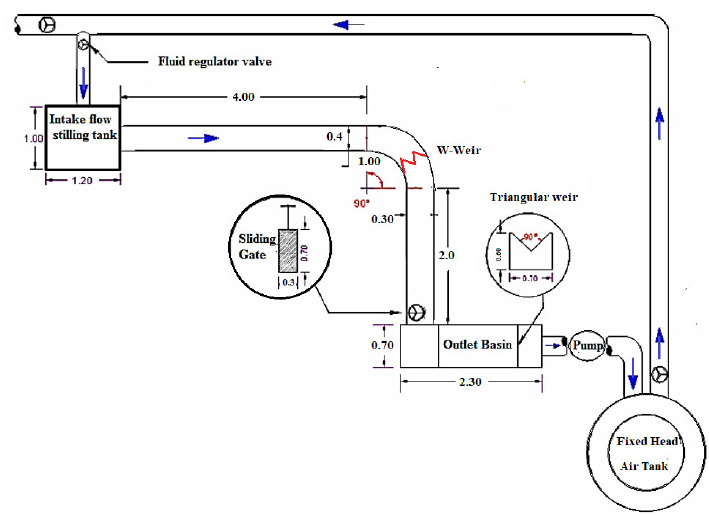
, the uniformity co ‐